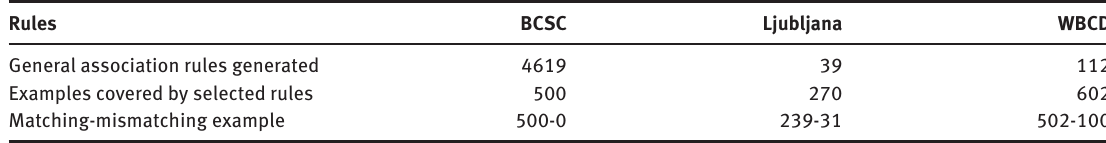
Table 4: Number of General Association Rules Obtained for All Three Breast Cancer Data Sets Used for Feature Selection. Rules BCSC Ljubljana